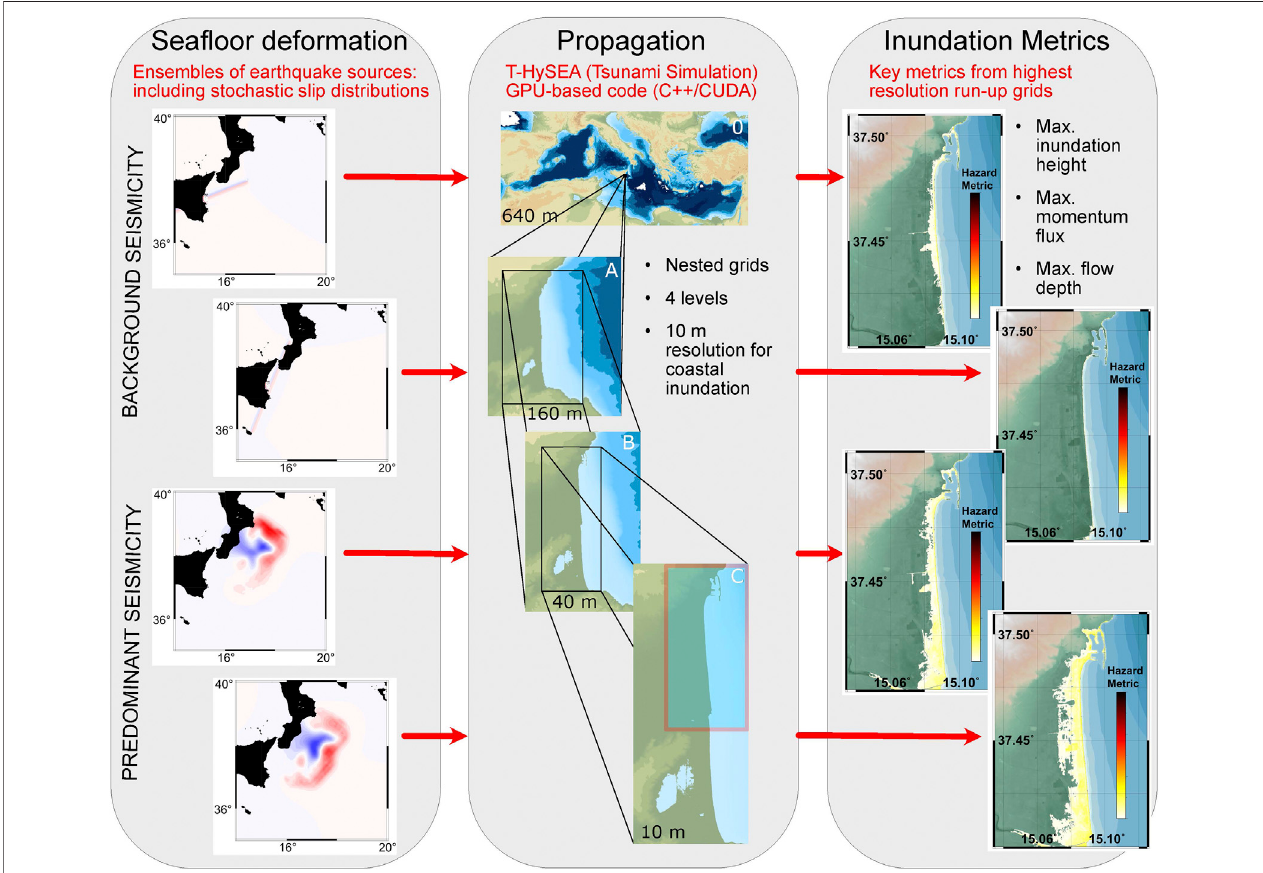
FIGURE2| Overviewofsimulationprocess,fromsourcemodelsandsea fl oordisplacements (left) forBSandPSsources,thenestedgridprocedure (center) ,and tsunamiinundation (right) fordifferentscenarios. TheTsunami-HySEA codesimulates the fl owdepthon theco-seismically deformedbathymetrywhichisdifferentfrom scenario to scenario. The aggregated hazard takes this into account. See Scala et al. (2020) for a detailed description of the stochastic slip distributions for the Predominant Seismicity sources.